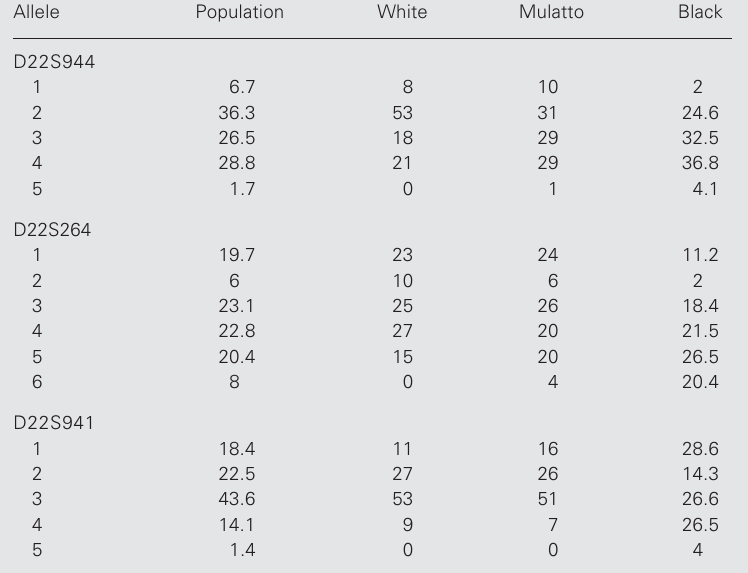
Table 1. Allele frequencies of the studied